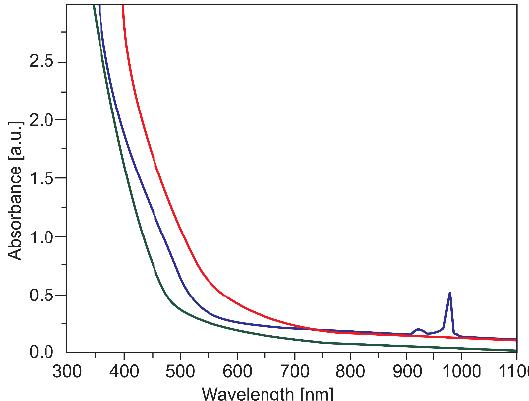
Figure 2. Absorbance spectra of ZnSe (green line), ZnSe:Eu 3+ /Yb 3+ (blue line), and ZnSe:Eu 3+ (red line) at 300 K.